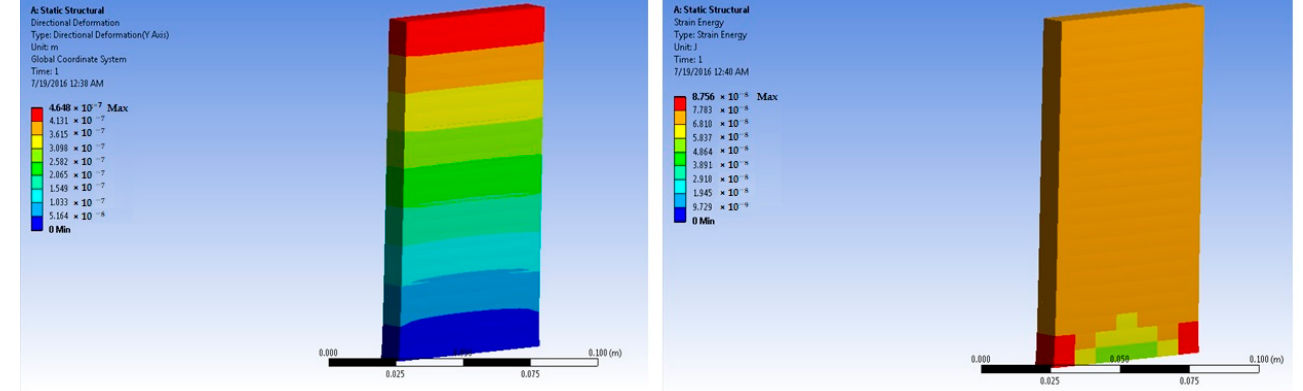
Figure 20. Three percent fine-aggregate-based concrete slab at 700 × 10 5 N force (deformation and strain energy).